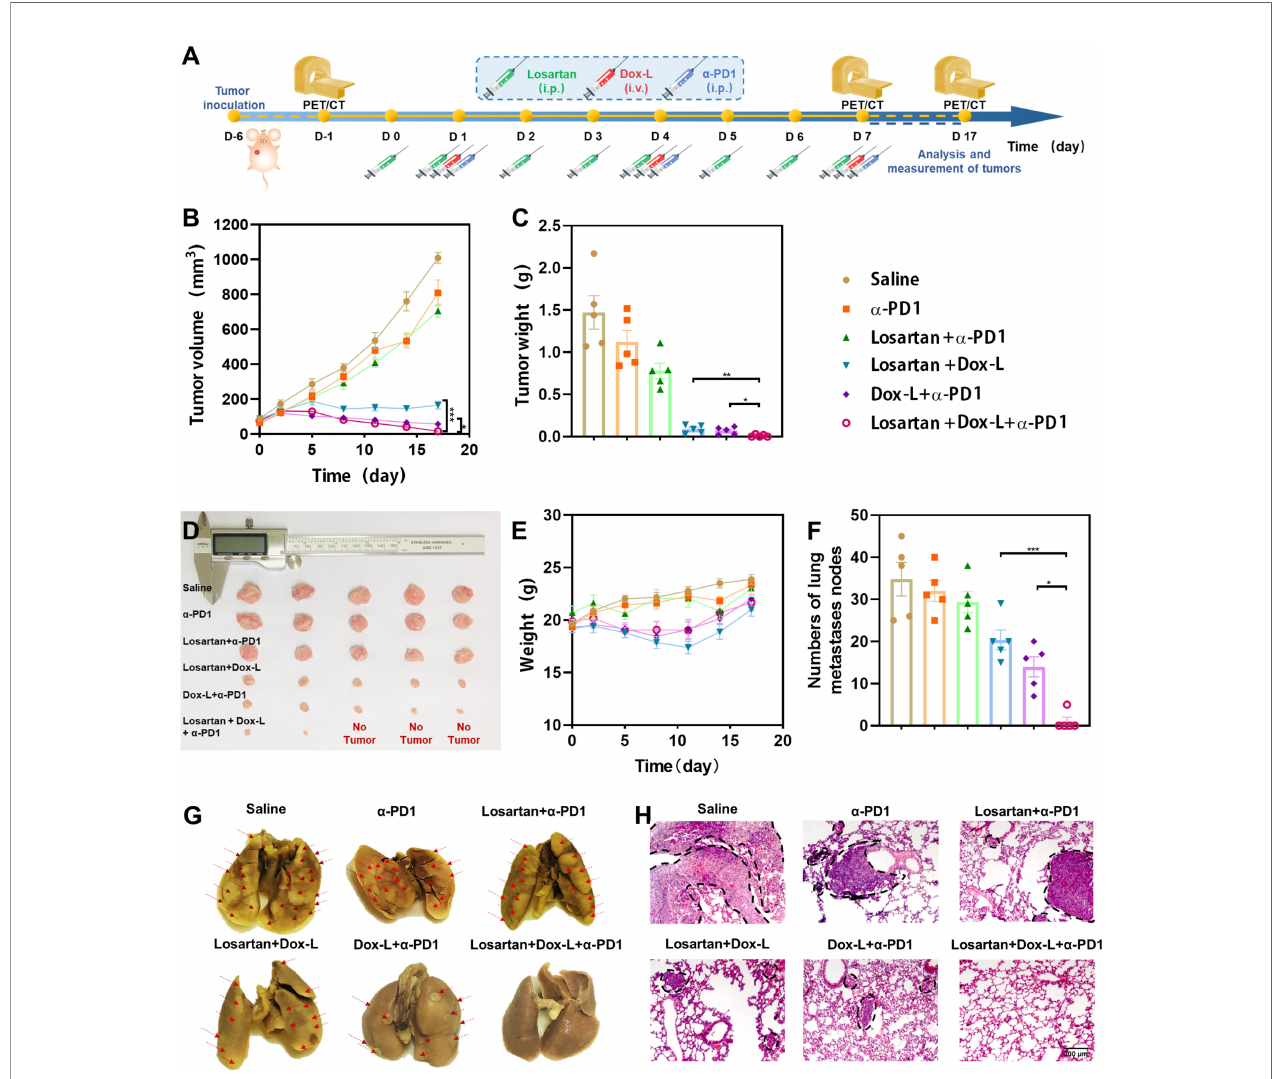
FIGURE 2 | Antitumor effect of losartan, Dox-L plus anti-PD1 immunotherapy in orthotopic 4T1 tumor models. (A) Schematic illustration of combined treatment to tumors. (n = 5) (B) Tumor growth curves of different groups of orthotopic tumor-bearing mice after various treatments as indicated in the fi gure. (C) Average weights of tumors at the end of treatments. (D) Photographs of excised tumors at the end of treatments. (E) Weight of mice after different treatments. (F) The numbers of lung nodules were counted under an anatomy microscope (n = 5). (G) Representative Lung photographs of 4T1 murine breast tumors treated as indicated. Red arrows indicate the metastatic nodules on the lungs. (H) Representative H&E histopathological images of the lung metastasis. Scale bar = 200 m m. Data are expressed as the mean ± SEM. Statistical signi fi cances were calculated via Student ’ s t-test and one-way analysis of variance (ANOVA), * p < 0.05, ** p < 0.01 and *** p <